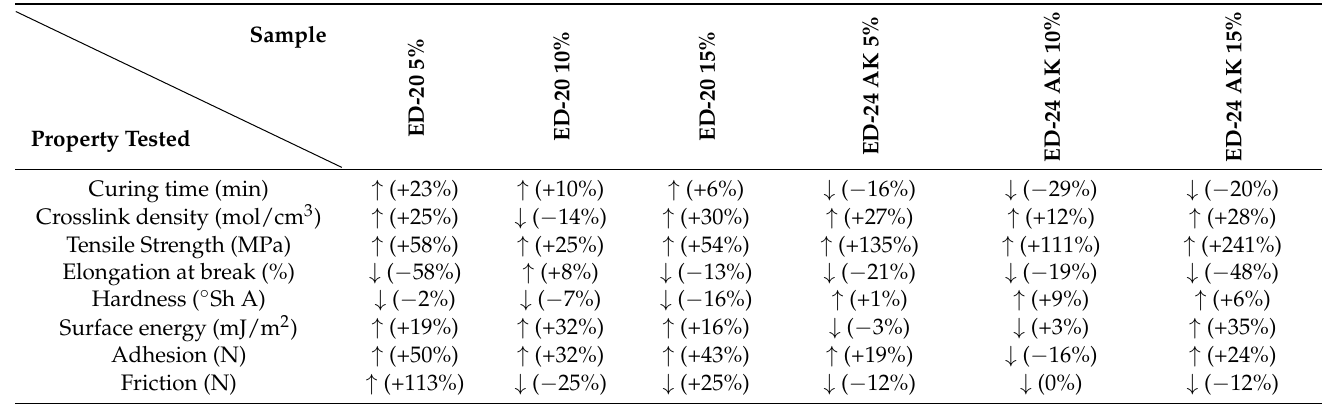
Table 5. Relative change in selected properties of NBR vulcanizates as a result of their modification with epoxy dian